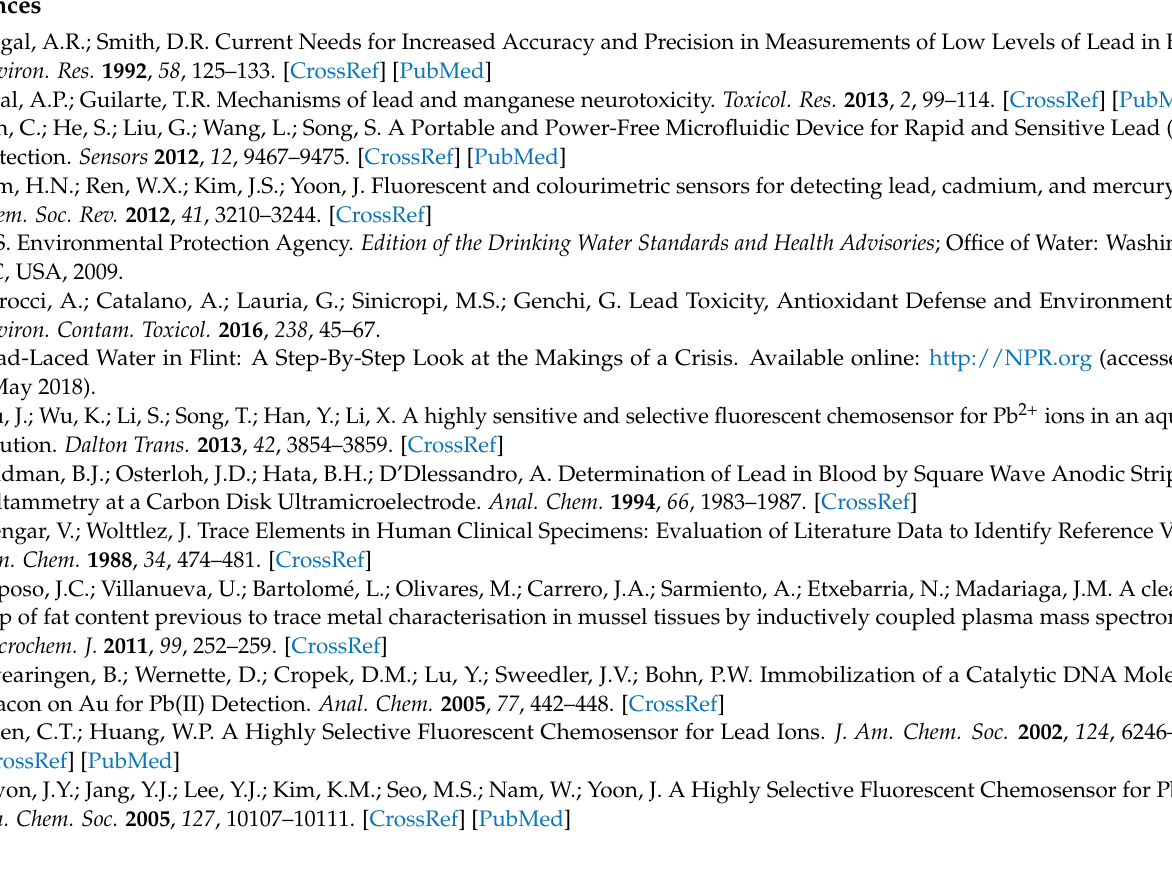
Pb 2+ and other metal ions was 1 × 10 − 4 M. Figure S8: Cell viability assessment of WMED in cervical cancer cell line HeLa did not show any significant toxicity up to 0.2 mg/mL concentration of WMED. Figure S9: Staining of Live HeLa cells with 0.06 mg/mL WMED Confocal microscopy images at 100 × Magnification. Live HeLa cells incubated with Lead at 0.1 µ M, 1 µ M, and 10 µ M concentration for 30 min and then WMED for 1 h. Spectra recorded for WMED at λ ex 405 nm/ λ em 450–550 nm. Nucleus is stained with TO-PRO nuclear dye λ ex 641 nm/ λ em 661